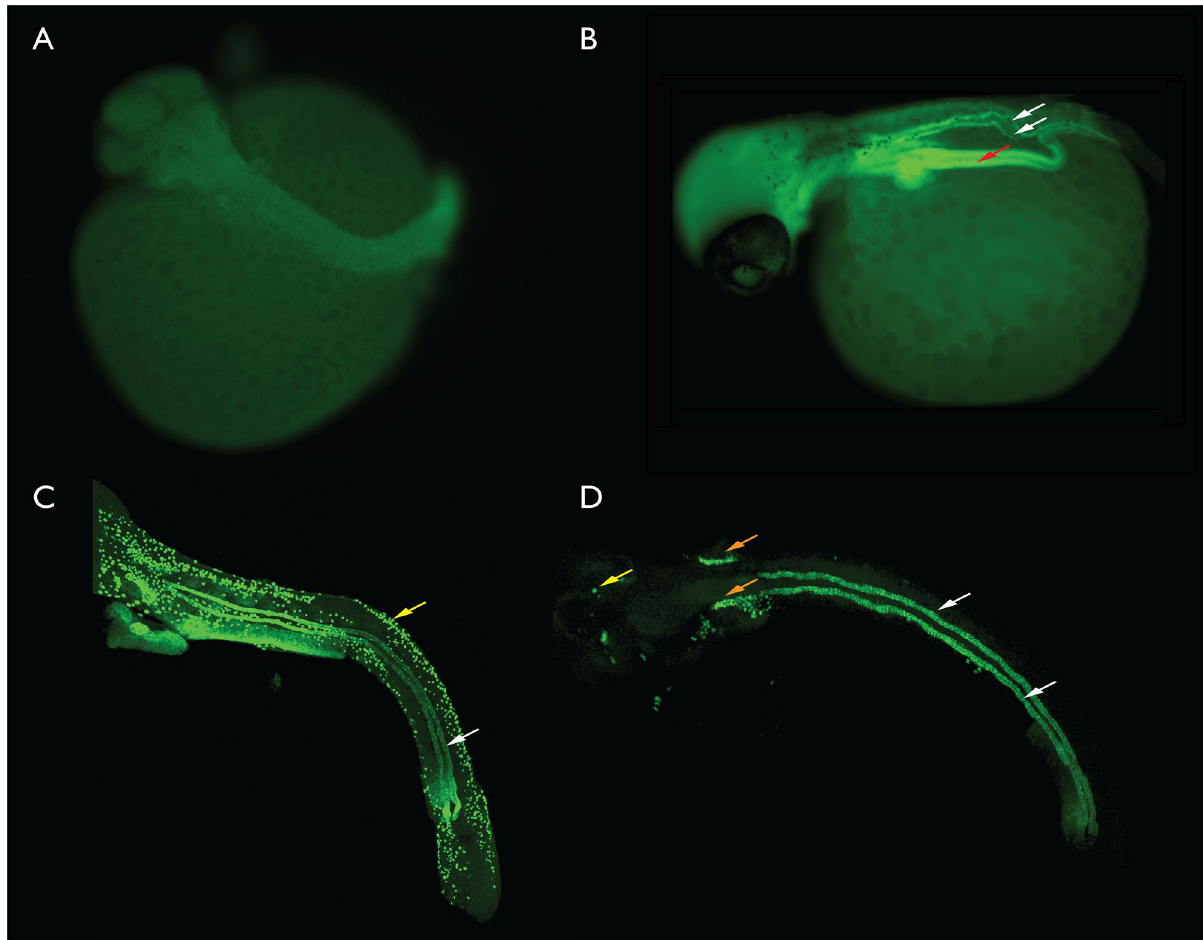
Fig 5. Fluorescent in situ hybridization based labelling of atp1a expression in the developing kidney of bay pipefish embryos. A. Late segmentation stage, no kidney is visible. B. Early pharyngula, paired kidney tubules are present and atp1a positive (white arrows). The gut tube is also fluorescent (red arrow). C. Scanning confocal generated image stack illustrating the kidney tubules (white arrow) and ionocytes (yellow arrow) in a late pharyngula embryo. D. Late pharyngula scanning confocal generated image stack. This stack was collected only in the plane of the kidney so most other labelled structures were not present. An unknown structure (orange arrows), possibly the developing gills and some ionocytes (yellow arrow) were also present in the image stack. For the purpose of scale, the eye in the early pharyngula in panel 5B is approximately 150 microns in diameter.